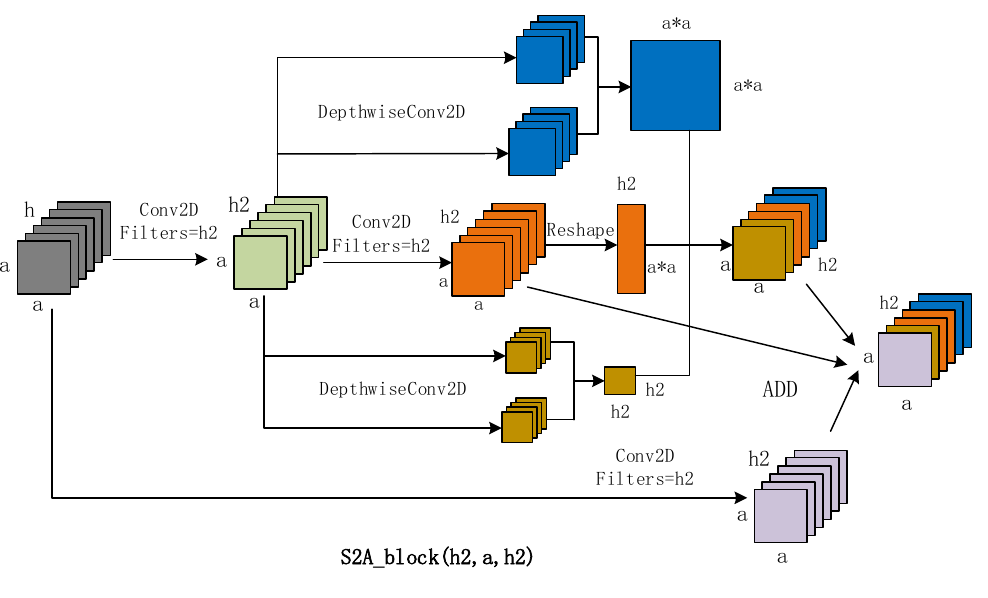
Figure 2. S2A block.